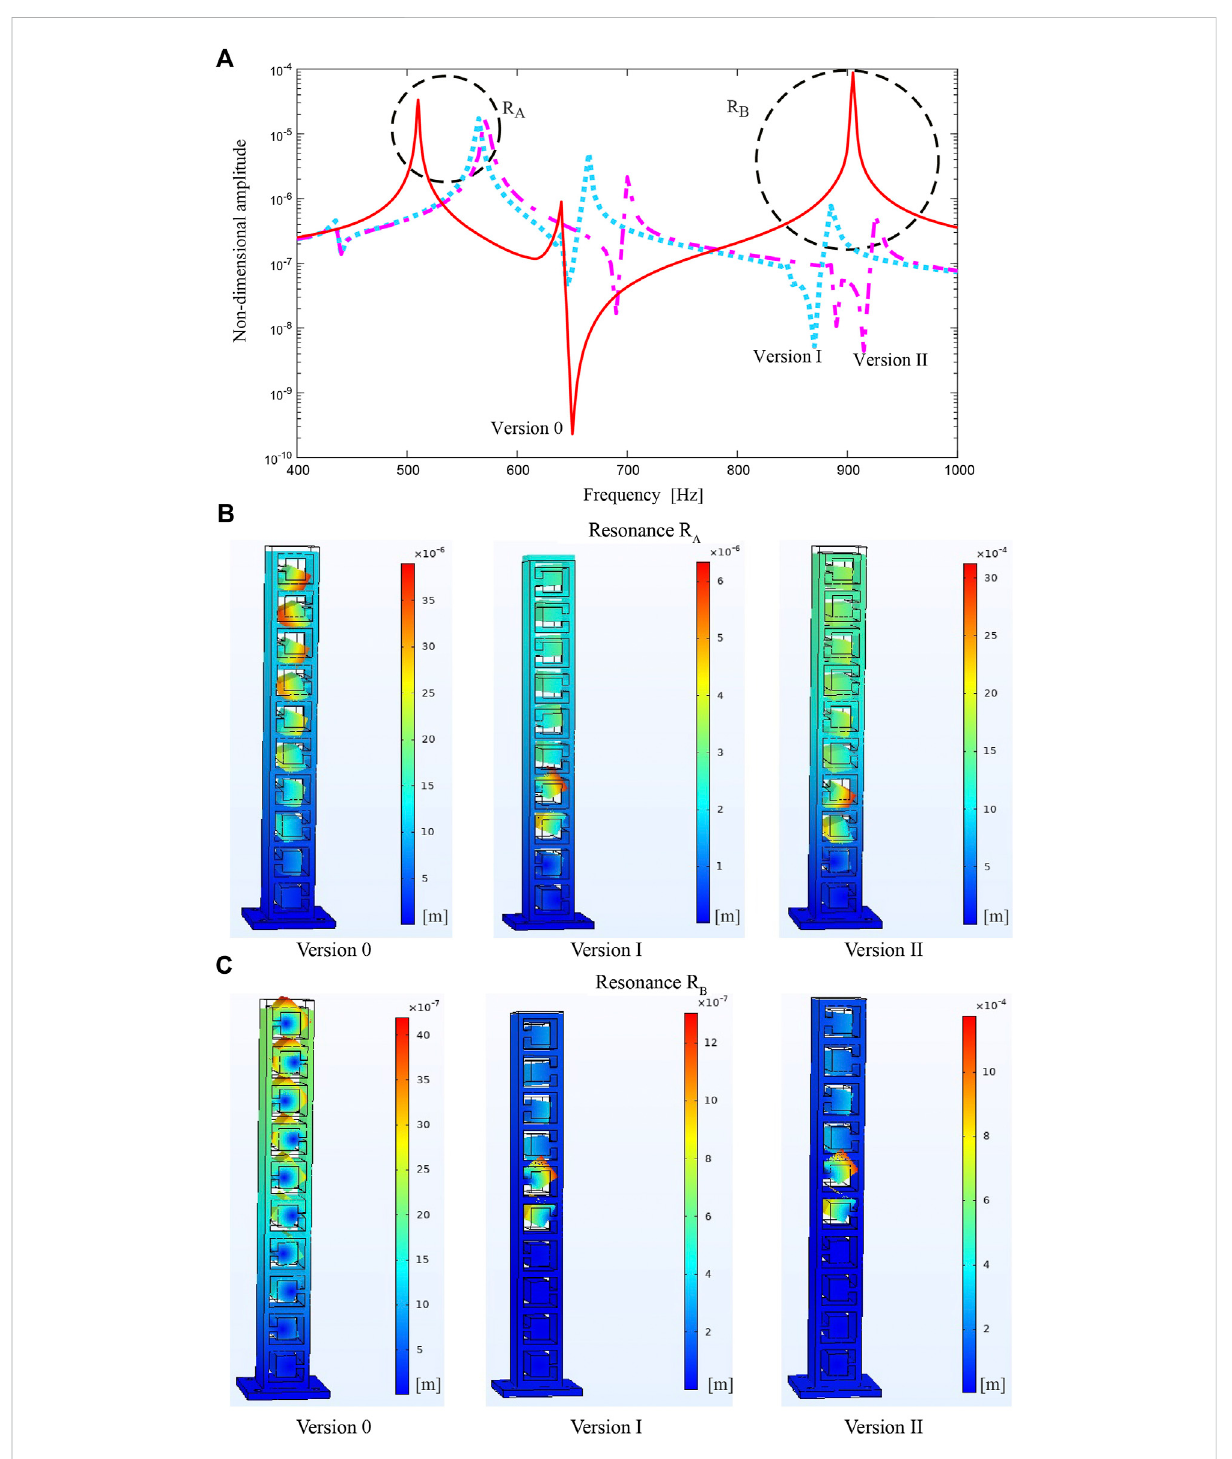
FIGURE 12 Numerically obtained results for the dynamics of internal oscillators for Versions 0, I, and II; (A) amplitude-frequency response curves; (B) presentations of the dynamics at the resonance R A ; (C) presentations of the dynamics at the resonance R B